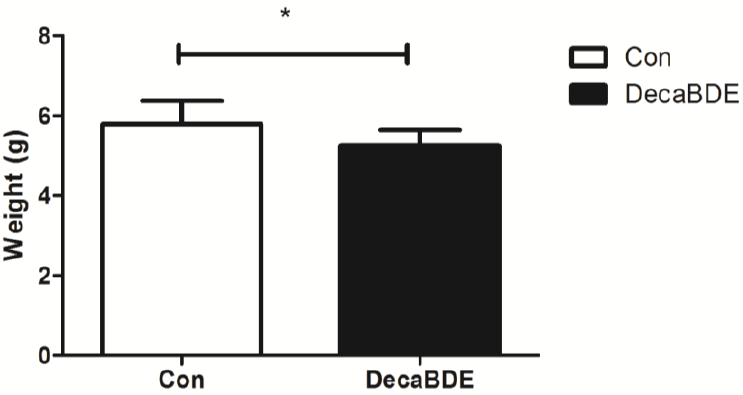
Figure 4. Comparison of the birth weight of newborn pups between the control group and DecaBDE-treated group; *: p = 0.0132.